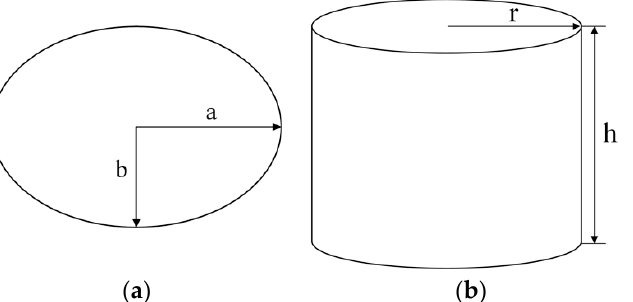
Figure 1. Calculation principle of elliptical radiation patch: ( a ) elliptical radiation patch principle; ( b ) cylindrical oscillator.